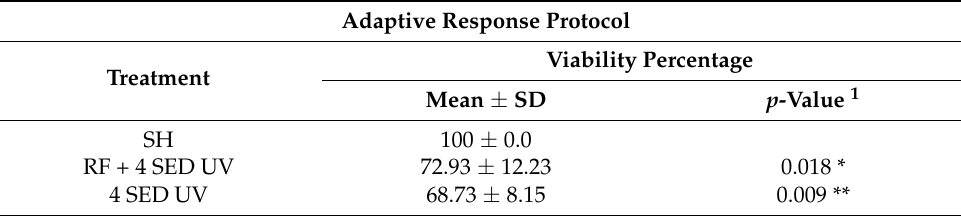
Table 2. Cell viability results under the adaptive response protocol with the 24 h continuous 1.5 W/kg SAR Wi-Fi exposure followed by 4 SED UV exposure.